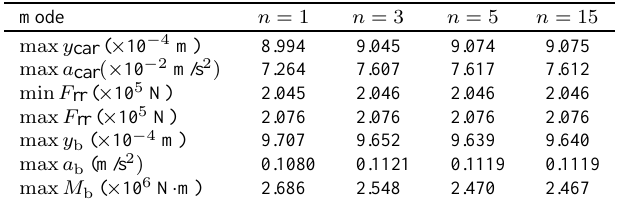
Table 1 The dynamic responses of the vehicle-bridge interaction system with var-